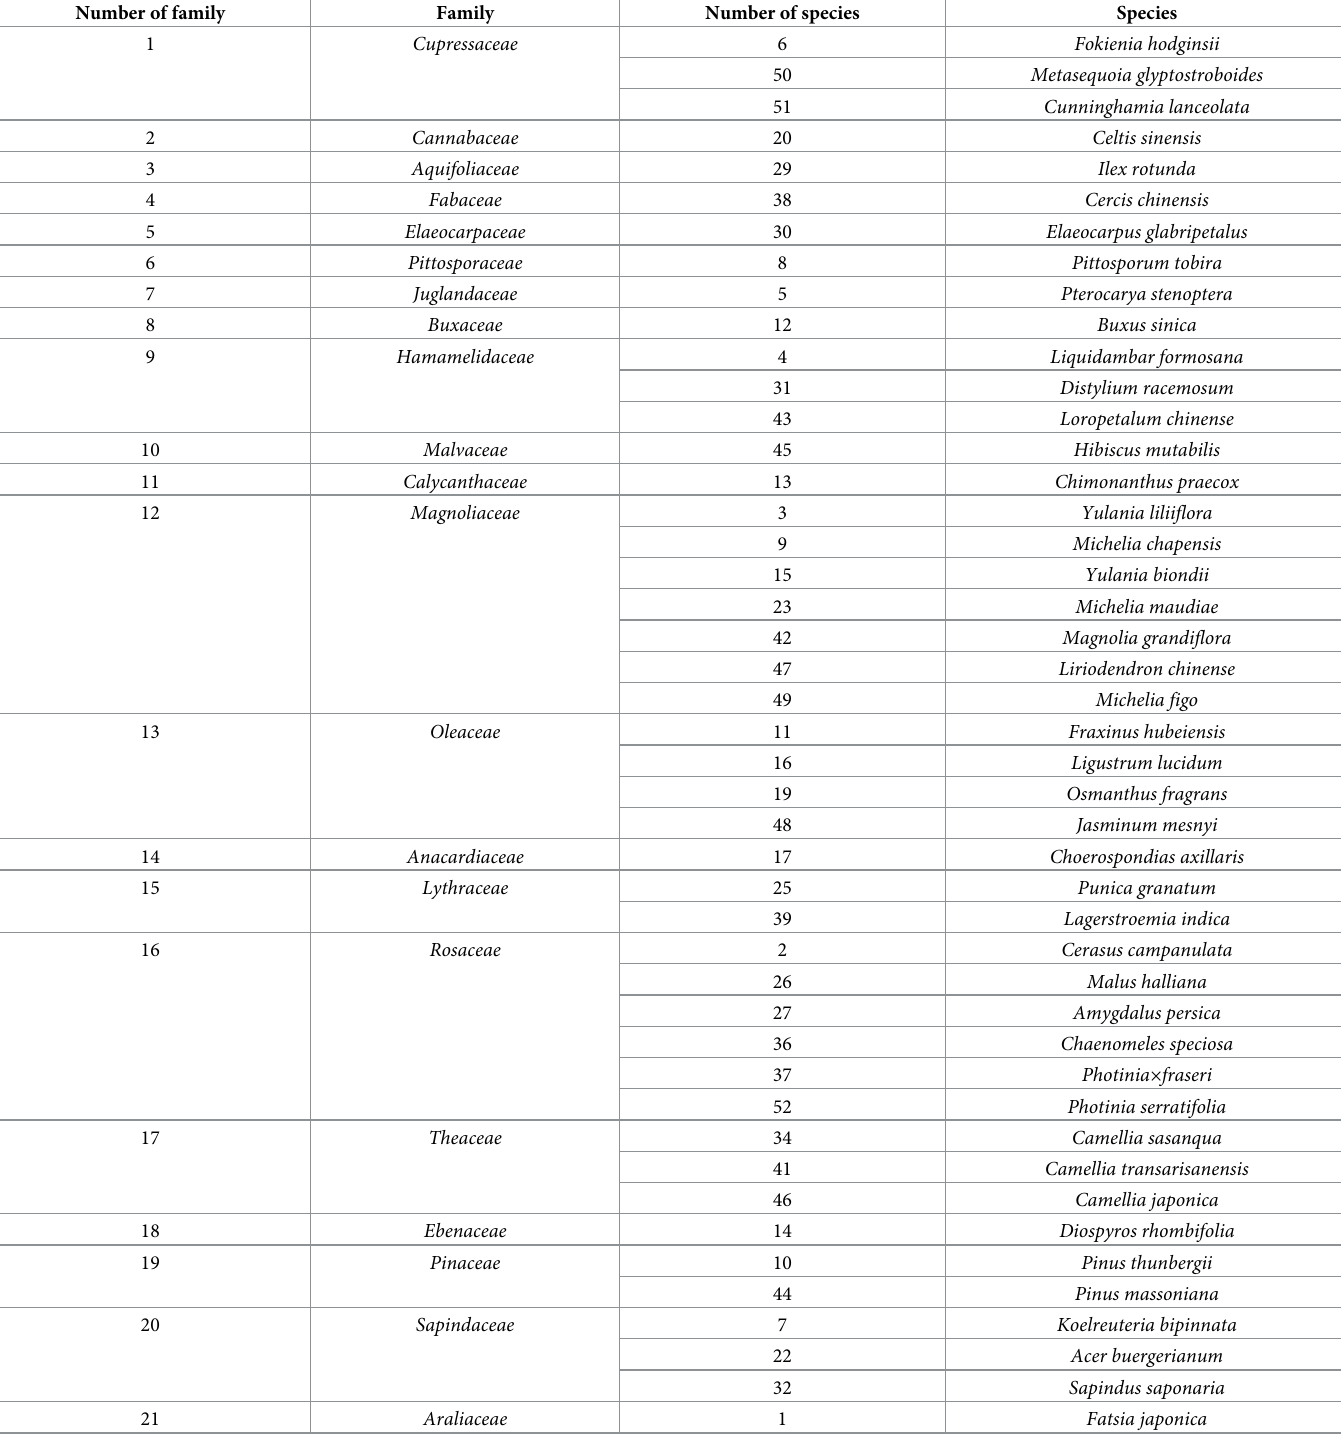
Table 1. The species, families and numbers of plants used in this study. Number of